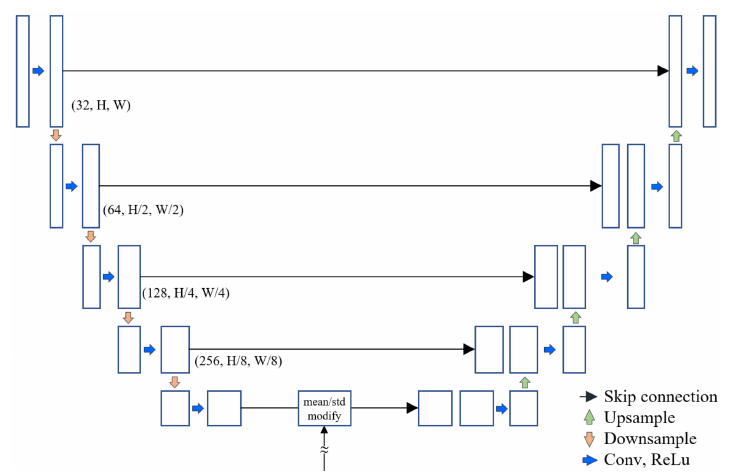
Figure 5. More detailed feature map size and channels for